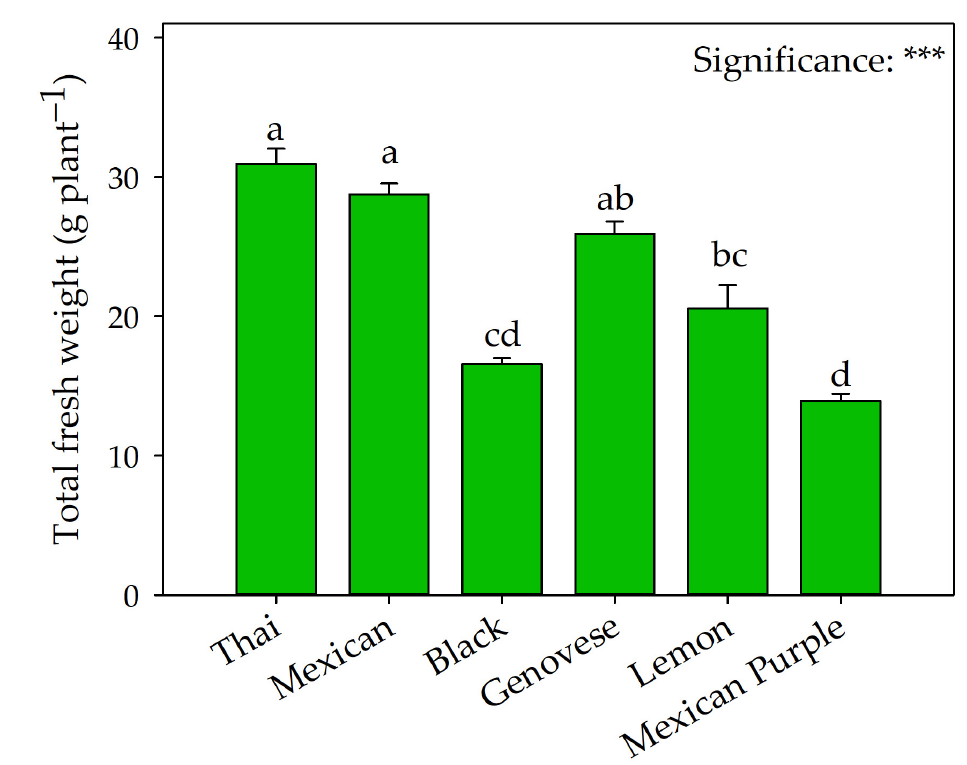
Figure 1. Comparison of Thai, Mexican, Black, Genovese, Lemon, and Mexican Purple basil on total fresh weight. Data are mean values ± standard error, n = 4. Mean comparisons were performed by Tukey HSD test. Different letters indicate significant mean differences. *** denote significant effects at p ≤ 0.001. Table 1. Comparison of Thai, Mexican, Black, Genovese, Lemon, and Mexican Purple basil on bio ‐ metric parameters.